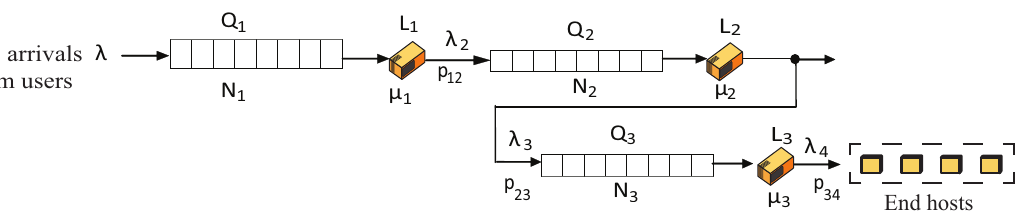
Figure 2. The interconnections of the Fully-Populated Network (FPN) of Figure 1, as depicted from the Probabilistic Model (ProMo) point of